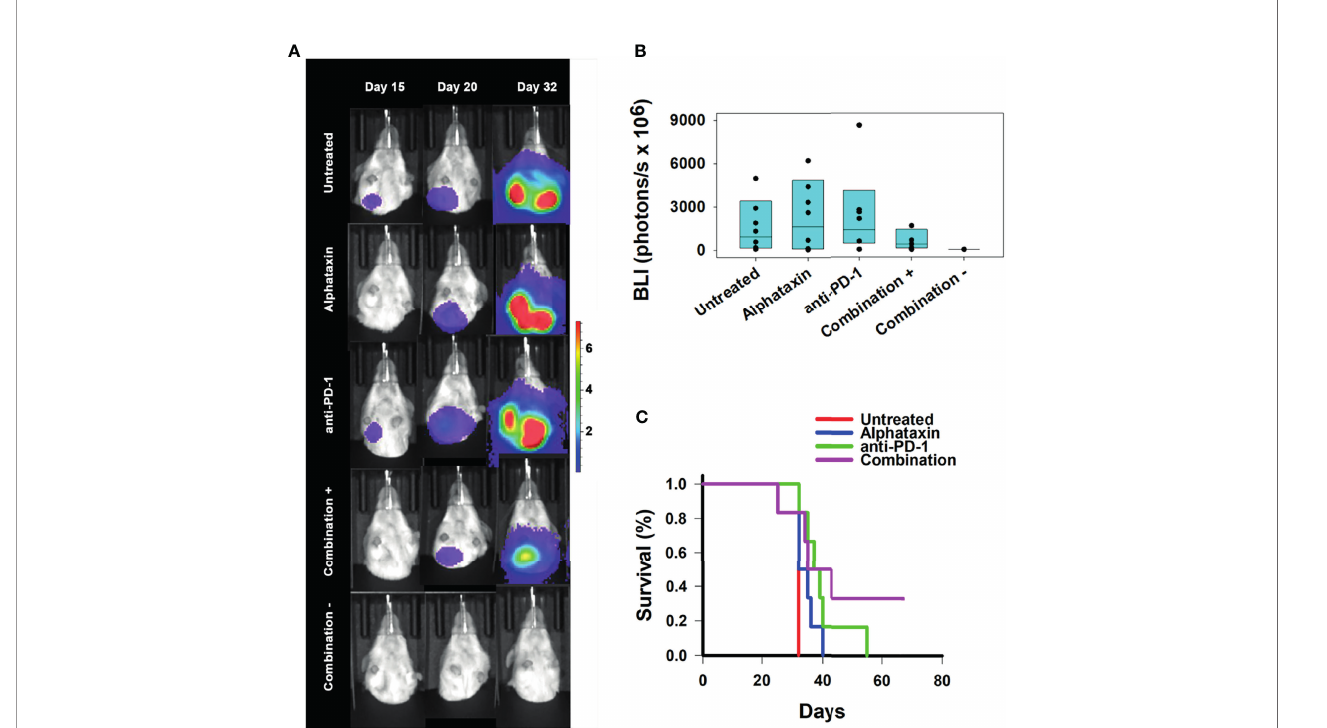
FIGURE 7 | Suppression of Lung Metastasis Achieved by Treatment with Alphataxin and an Anti-PD-1 Antibody. Mice were orthotopically implanted with 5x 10 3 Renca-GL cells, and treatment was initiated the following day. (A) Longitudinal shielded (ventral) images of the metastatic lung tumor growth. A representative animal that showed similar bioluminescence with at least 2 other animals within the same treatment arm after 20 days of treatment was selected from each treatment arm. The mice in the combination treatment arm were bifurcated into 2 groups, those with kidney tumors ( “ Combination + ” , 4 th row, n = 4) and those without kidney tumors ( “ Combination − ” , 5 th row, n = 2). The luminescence color scale represents photons/sec/cm 2 /steradian x 10 7 with minimum 4.8e5 and maximum 7.29e7. (B) After 32 days of treatment, there was a 4-log difference in the 25% median lung BLI between the combination treatment arm (2.9x10 6 photons/s) and untreated arm (2.6x10 10 photons/s) and a 1-log difference in the 75% median value between the combination treatment arm (8.4x10 9 photons/s) and the untreated arm (5.6x10 10 photons/s), which clearly demonstrates that the combination treatment dramatically decreased metastasis with practical statistical importance. The metastatic tumor volumes were not normally distributed, and the medians are shown within each box plot with individual lung BLI values. (C) Average survival of mice in the combination treatment arm (violet, 45 days) was signi fi cantly greater ( P = 0.02) than that in the untreated (red, 32 days), Alphataxin (blue, 33 days) or anti-PD-1 (green, 40 days) treatment arms. Increased life span versus untreated mice (Treatment/Untreated*100% - 100%) was 22 days in combination-treated mice ( P < 0.01), 19 days in anti-PD-1-treated mice ( P < 0.05), and 5 days in Alphataxin-treated mice. All untreated mice were euthanized after 32 days due to being moribund. In contrast, two combination-treated, healthy mice exhibiting no evidence of tumors were euthanized after 67 days to end the